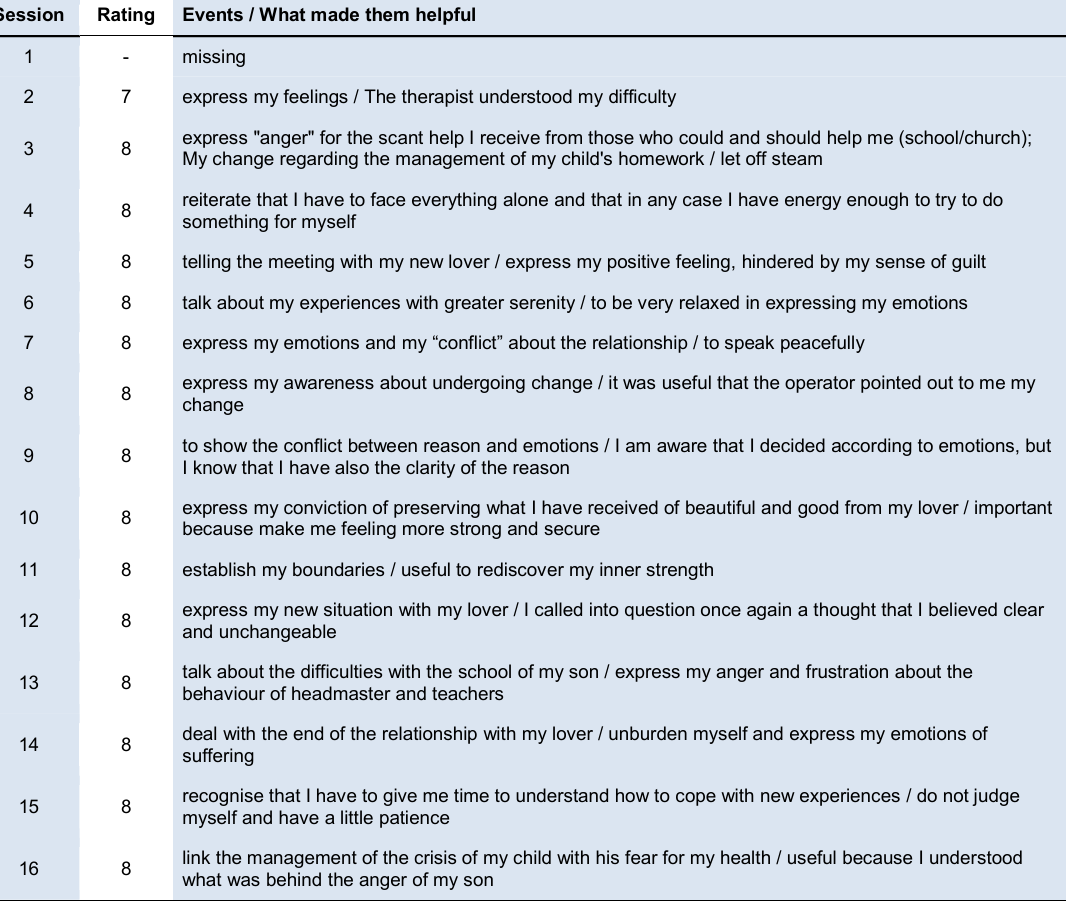
Table 3: Penelope's helpful aspect of therapy - HAT Note. The rating is on a scale from 1 to 9; 1 = extremely hindering, 9 = extremely helpful. HAT = Helpful Aspect of Therapy (Llewelyn,